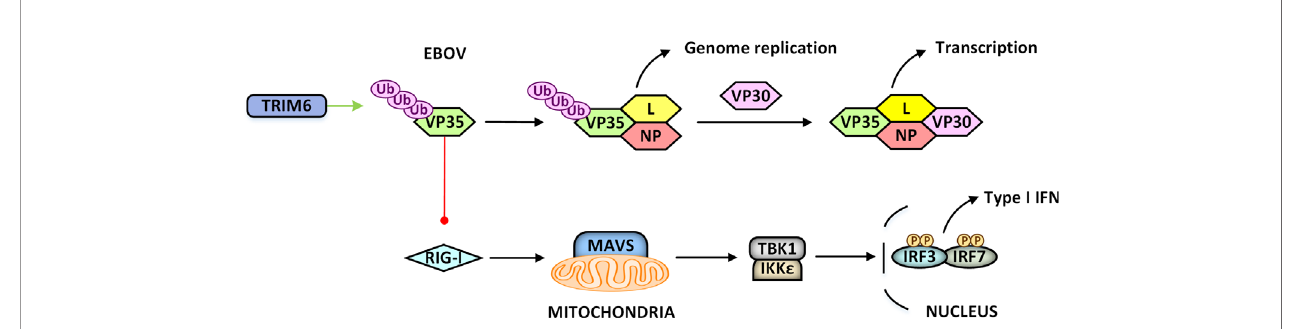
FIGURE 5 | Viruses “ domesticate ” TRIM proteins for their replications. VP35 protein of Ebola virus (EBOV) could serve as an essential cofactor of the viral polymerase, and a potent antagonist of RIG-I mediated innate immunity. TRIM6 can be recruited to ubiquitinate VP35 protein on K309, promoting virus replication by enhancing viral polymerase activity or decreasing its ability to antagonize RIG-I mediated innate